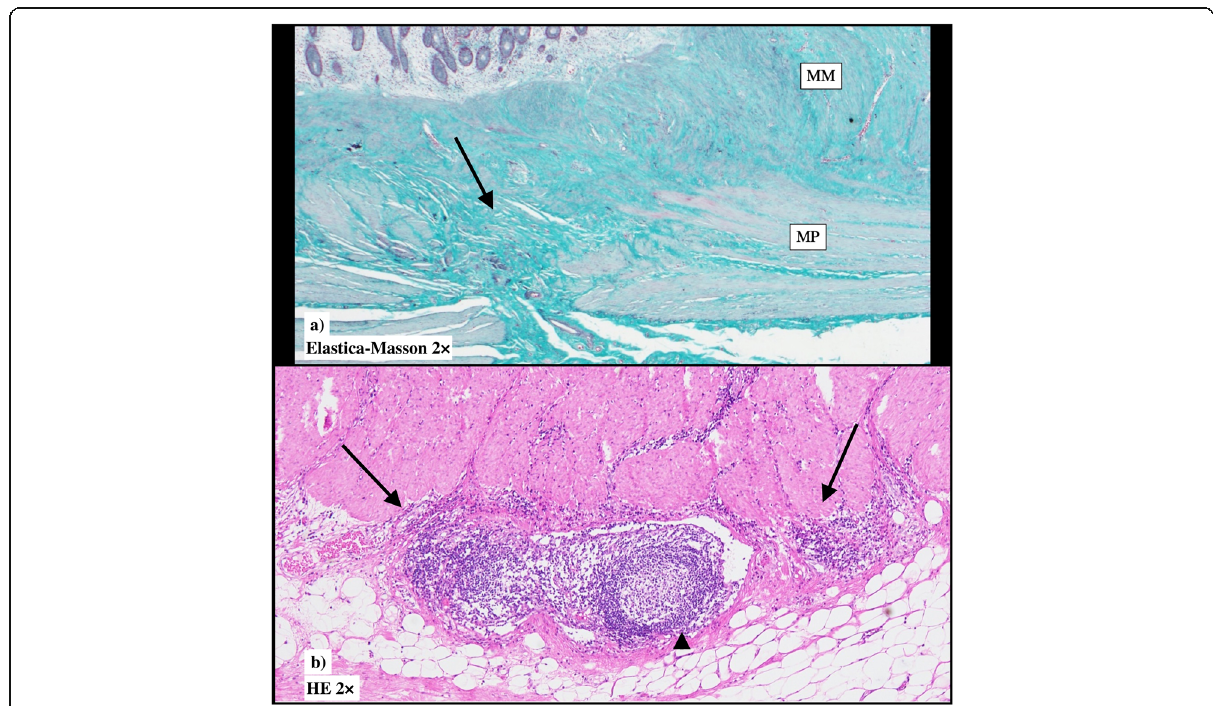
Fig. 7 Microscopic findings in the colon tissue near the main tumor suggesting pre-existing latent Crohn ’ s disease. a Scar formation (green) that penetrates the muscularis propria (arrow). b Lymphoid aggregate (arrows) and lymphoid follicles in the subserosa (arrow